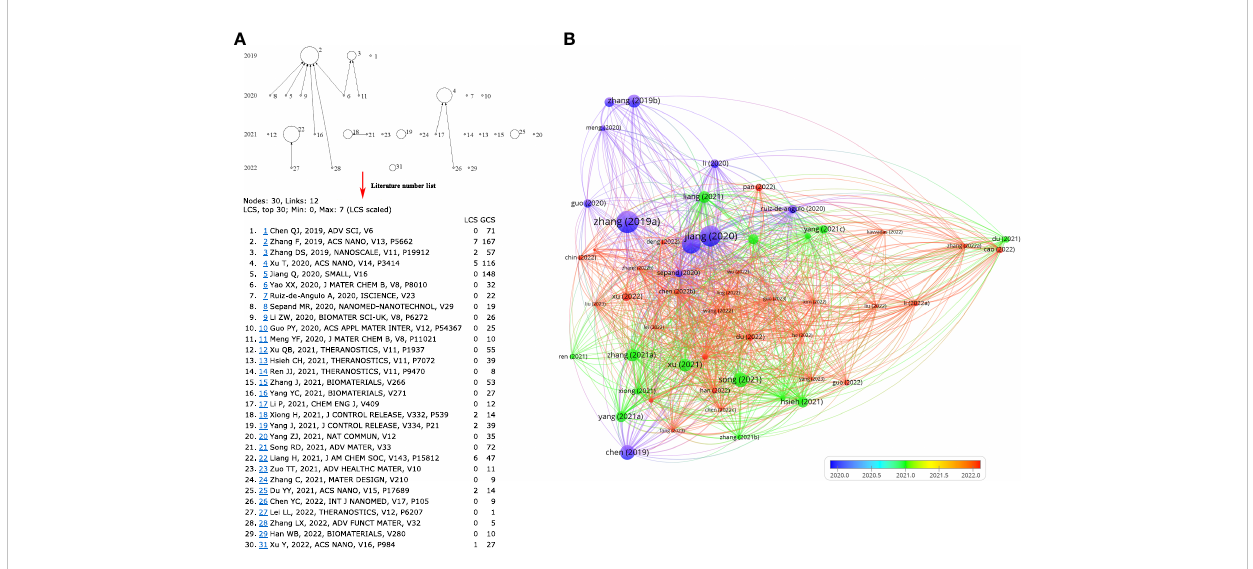
FIGURE 7 Data mining in nanoparticle-related articles. (A) Top 30 LCS of 53 documents. The analysis was performed by HistCite, the note of Top 30 LCS literature; (B) Literature coupling analysis by